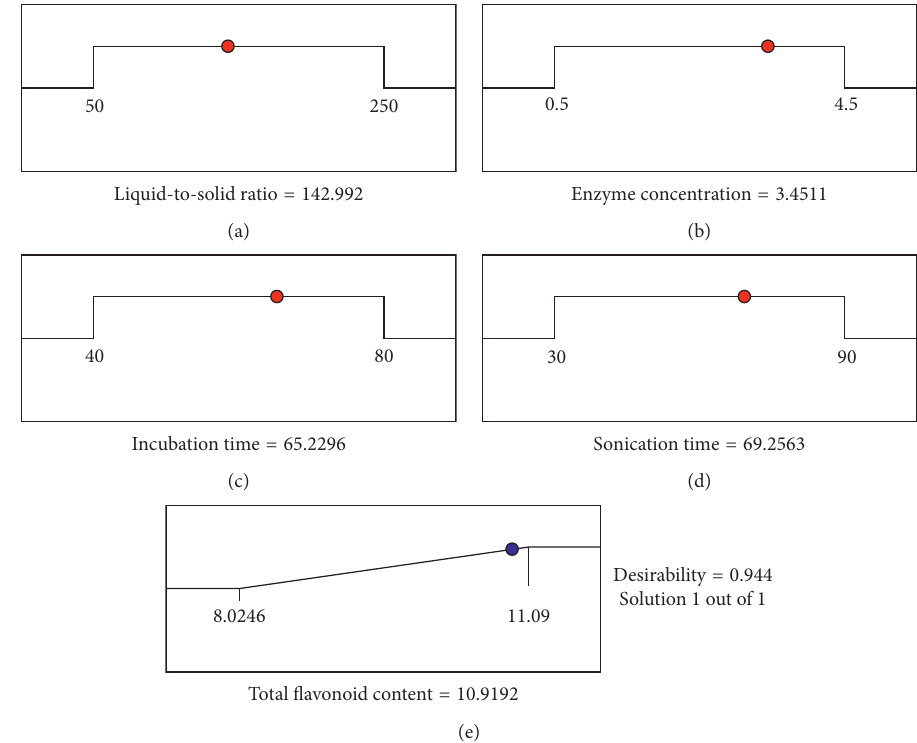
Figure 3: Desirability ramp for optimized conditions for extraction